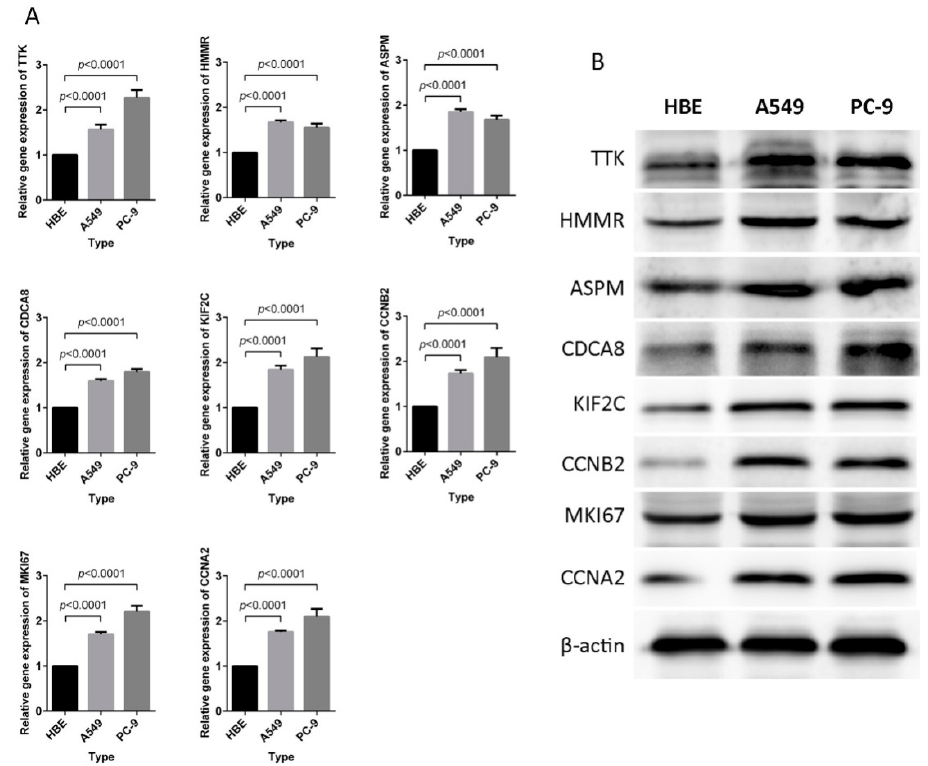
Figure 8. Expression profiles of eight signature genes in the HBE, A549, and PC-9 cell lines. ( A ) RT-PCR analysis of relative mRNA expression. The genes expression levels for each of the eight genes were significantly increased in A549 and PC-9 cells compared to HBE cells ( p < 0.0001). ( B ) Western blot analysis of protein expression levels. Every protein appeared to have higher expression levels in A549 and PC-9 cells compared with HBE cells. The measurements of mRNA and protein expression levels were performed in triplicate.